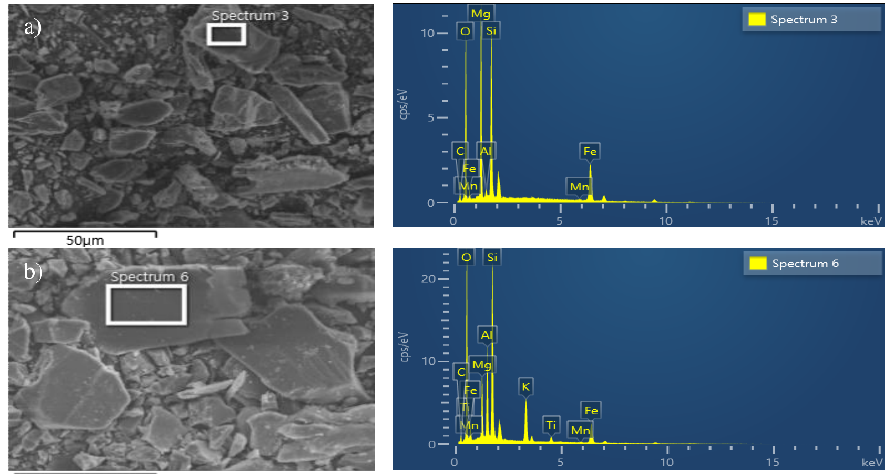
Figure 2. SEM images and EDS analyses for (a) SP and (b) CSP.